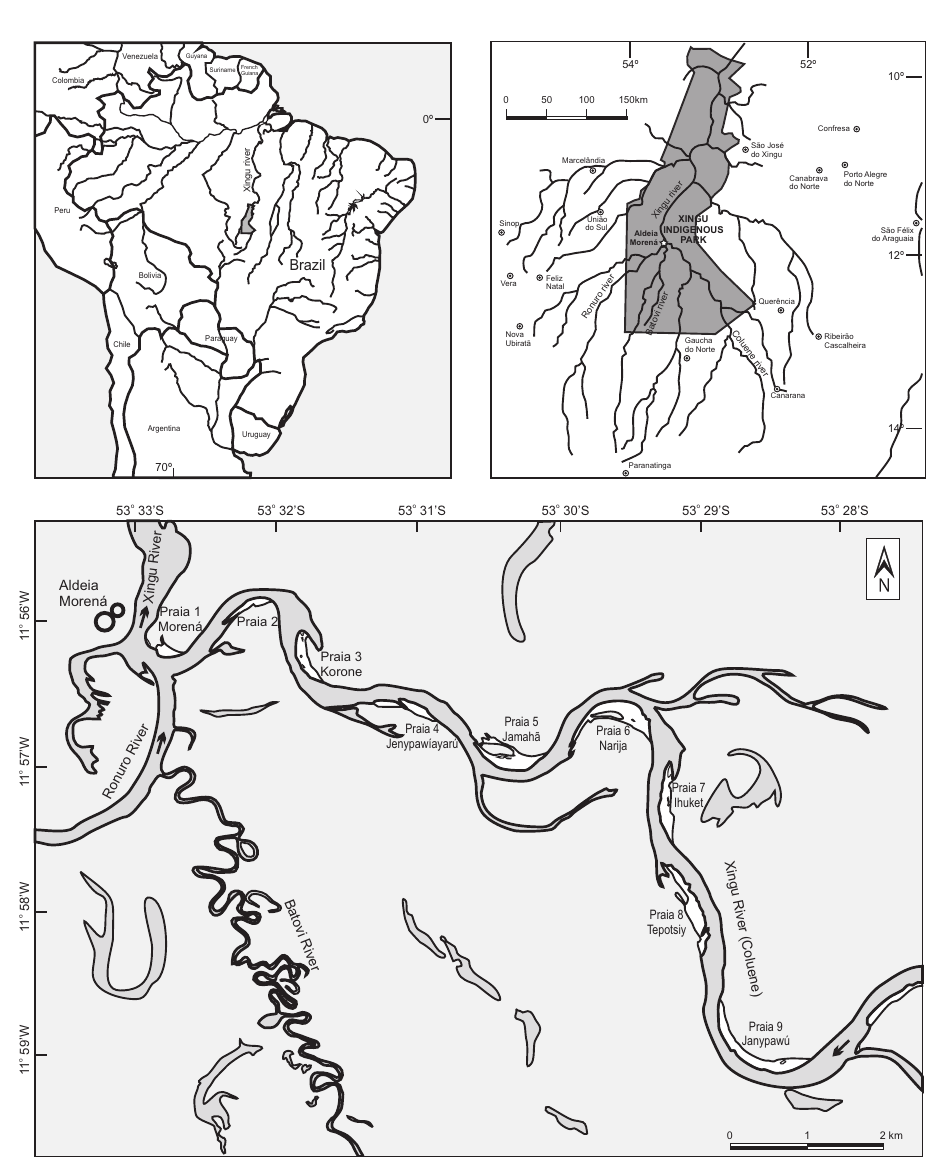
Figure 1. Localization map of the studied